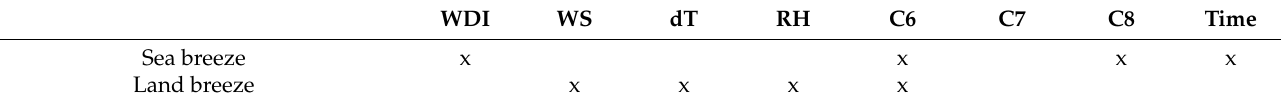
Figure 2. The mean hourly change in temperature mt ( ◦ C) and relative humidity mRH (%) ( left ), and mean wind speed mv (m s − 1 ) and vek mdir (deg) showing the mean vector wind direction ( right ), for selected cases with undisturbed coastal circulation at the AMS 3 Split-1 station from April to June 2007–2009. Table 3. The selected meteorological predictors in the stepwise MLR model at the AMS 3 Split-1 station where WDI (wind direction index) is calculated from hourly wind direction, WS is the hourly wind speed (m s − 1 ), dT ( ◦ C) is the hourly temperature deviation from the temperature at the time of the sea breeze lull, RH is the hourly relative humidity (%), C6, C7, and C8 ( µ g m − 3 ) are SO 2 concentrations at 6, 7, and 8 UTC, respectively, and the time is